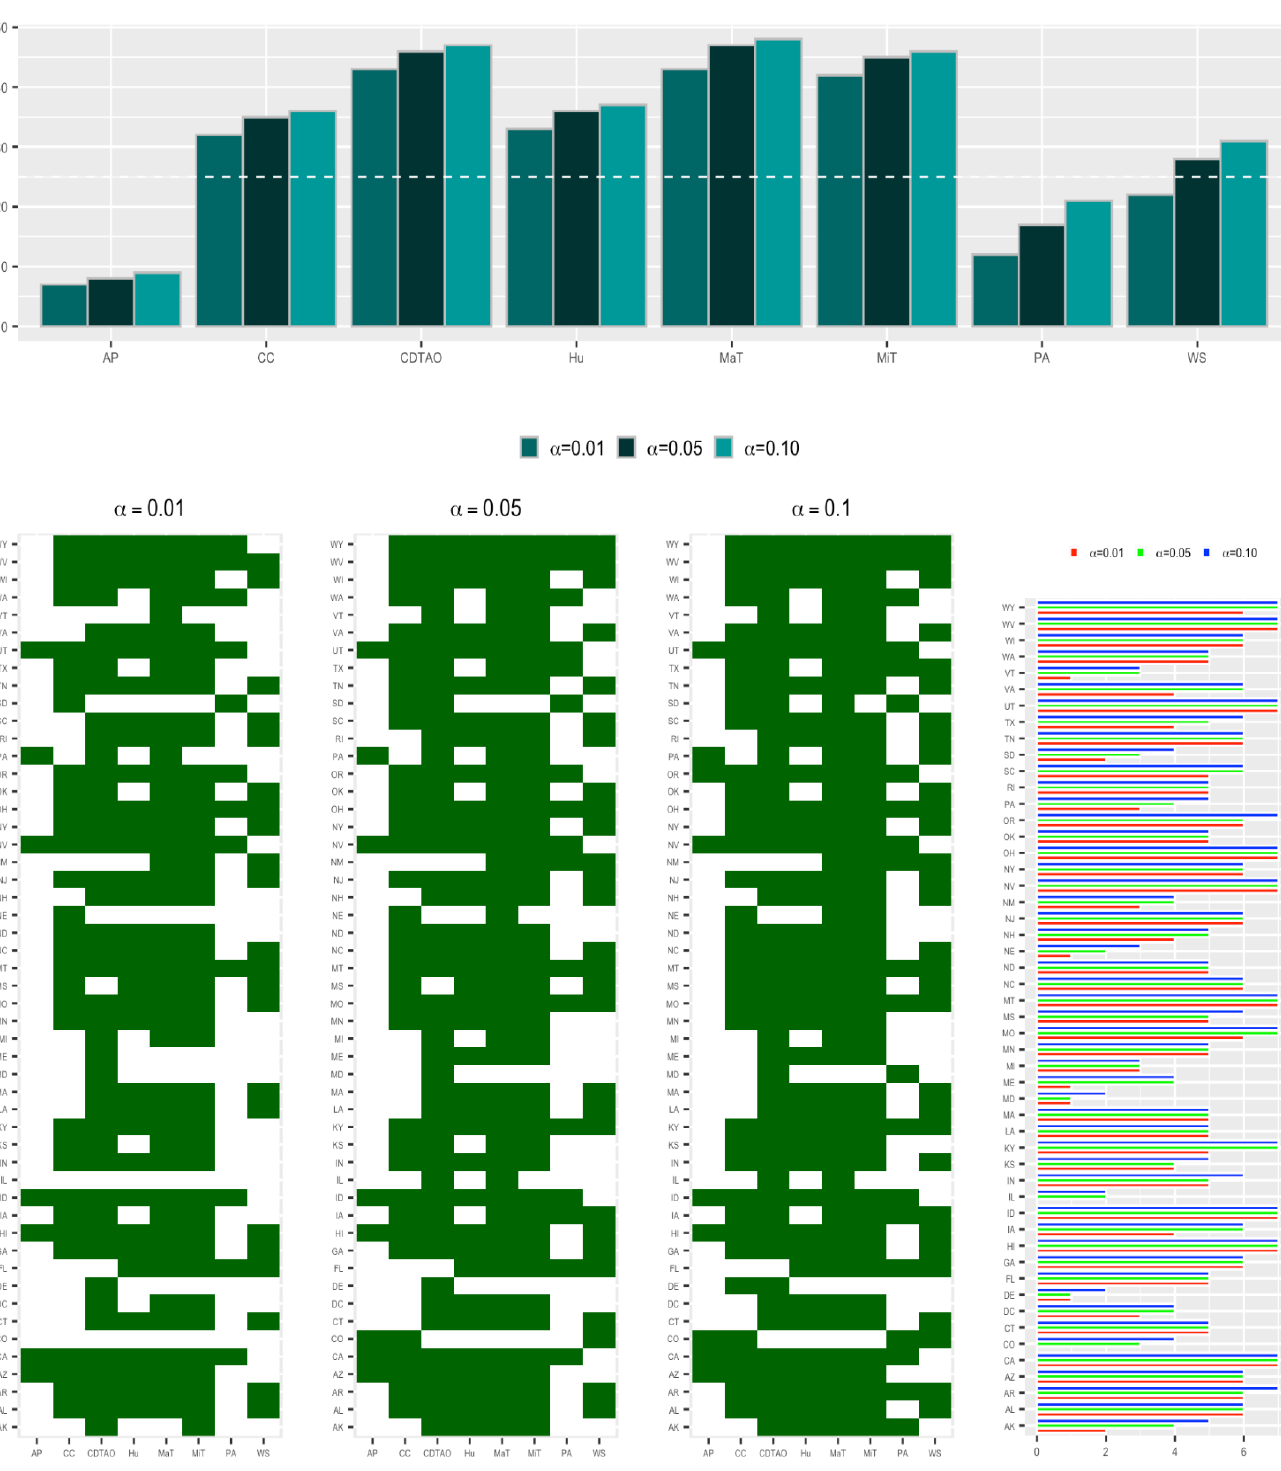
Figure 4. State-level combination of Spearman and Kendall tests. Two-dimensional barcode plots show whether a factor is significantly associated with a state by both the Spearman and Kendall tests (with squares in dark green color). The bar plot represents the number of states that are significantly associated with each factor with α = 0.01,0.05, and 0.10, respectively, by both the Spearman and Kendall tests. The horizontal line in the top subplot is equal to 25, which is approximately half of the total number of analyzed